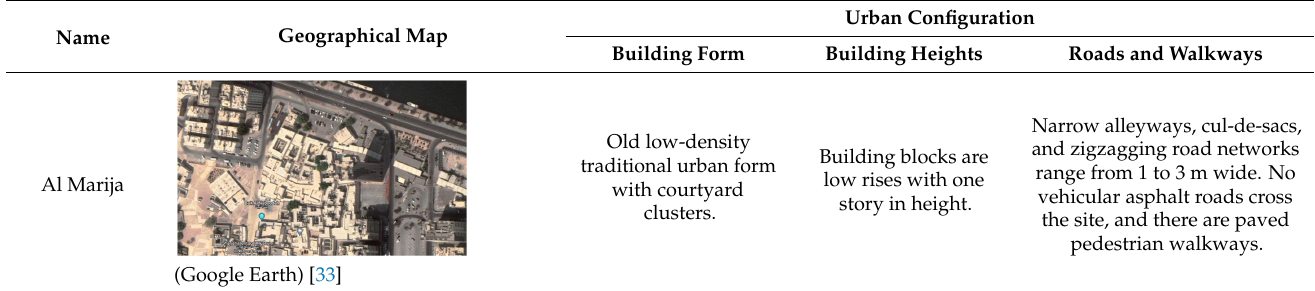
Table 2. Geographical locations and urban configurations for modern and traditional sites.